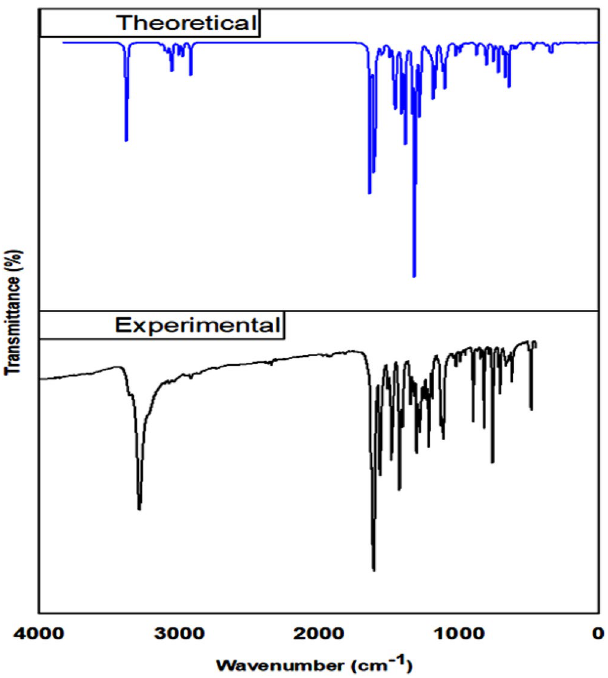
Figure 16. The FT-IR spectra of compound 12 experimental and theoretical calculated by B3LYP/6-31G(d,p) with